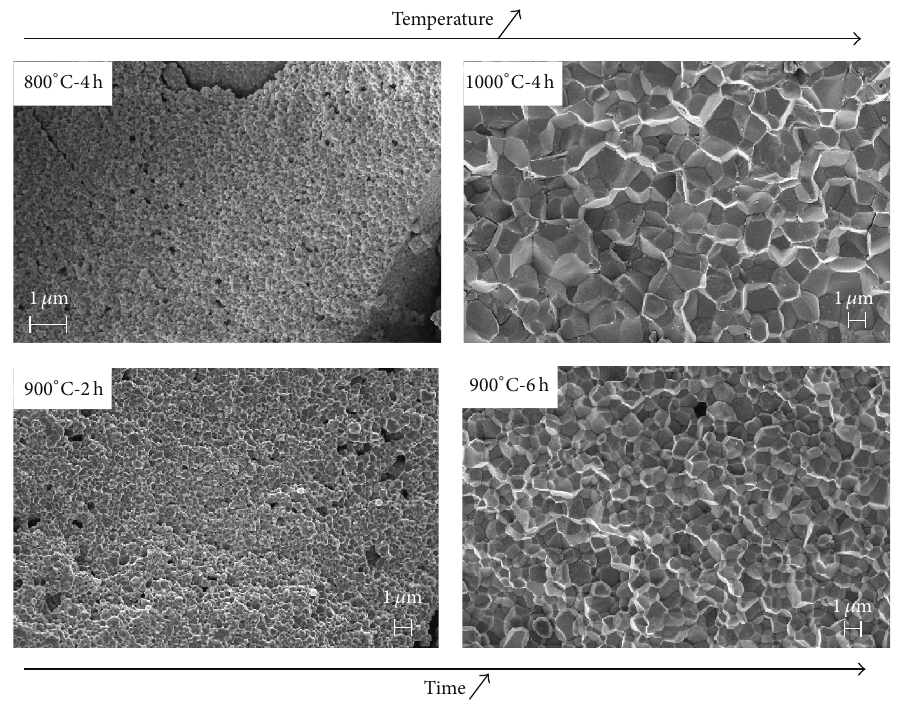
Figure 3: SEM images of PYN-PT 60% ceramics obtained after sintering at various temperatures and times.